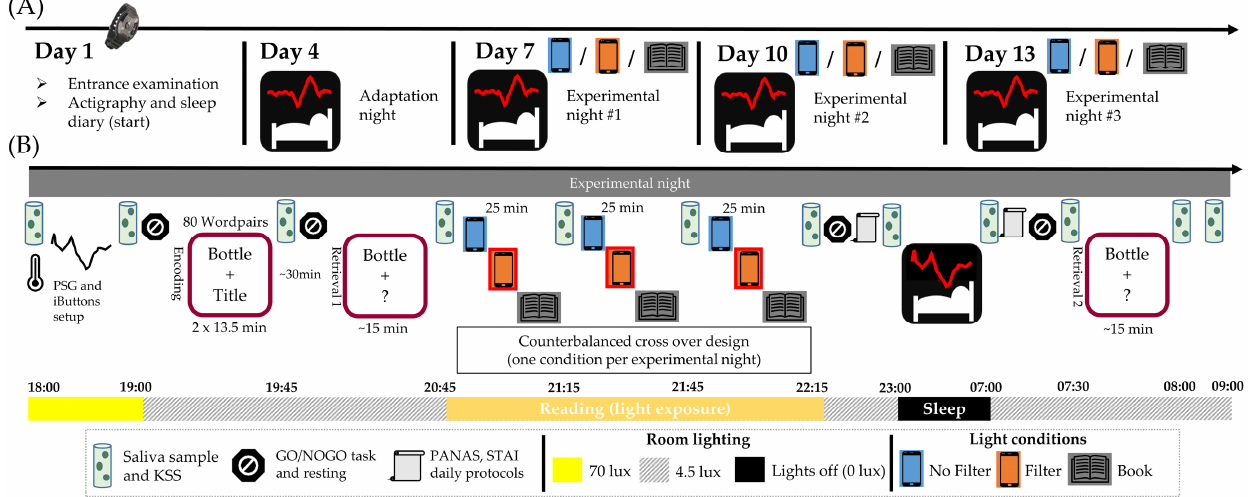
Figure 7. Study design [64]. ( A ) Overview of the general procedure, which covered a period of 13 days, including an entrance examination, one adaptation night and three experimental nights. ( B ) Detailed illustration of the study protocol in the experimental night. During the whole study period, participants’ sleep-wake rhythm was monitored by means of wrist actigraphy and sleep